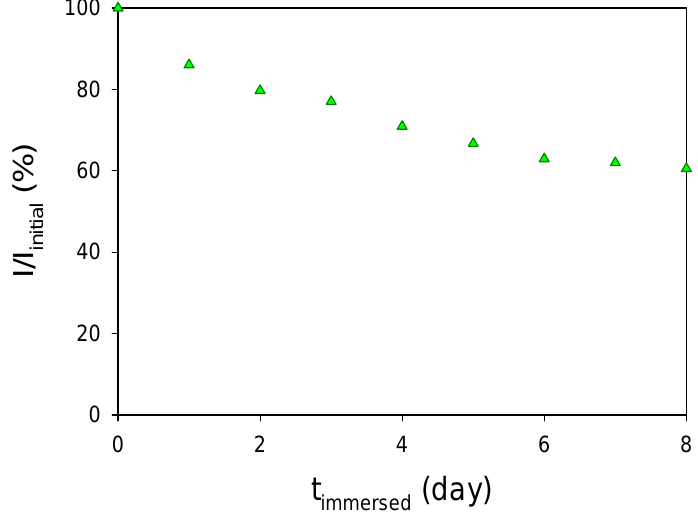
Figure 10. Luminescent signal change as AA-PSP immersed in water for eight